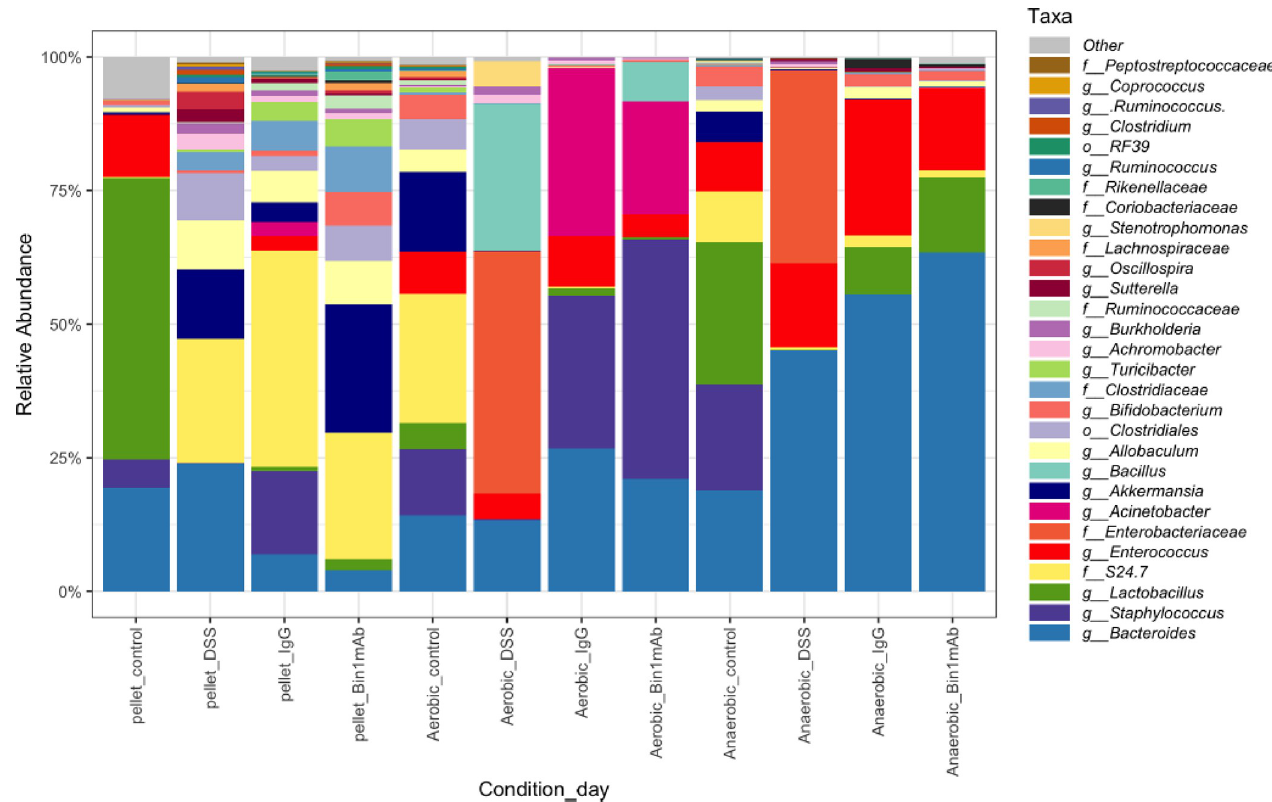
Fig 8. The relative abundance of the microbiome of the fecal pellets of mice from different treatment conditions. The bacteria of the genus Lactobacillus is totally absent in the UC mice. The UC mice is enriched in Enterobacteriaceae . (n = 3 mice per treatment).